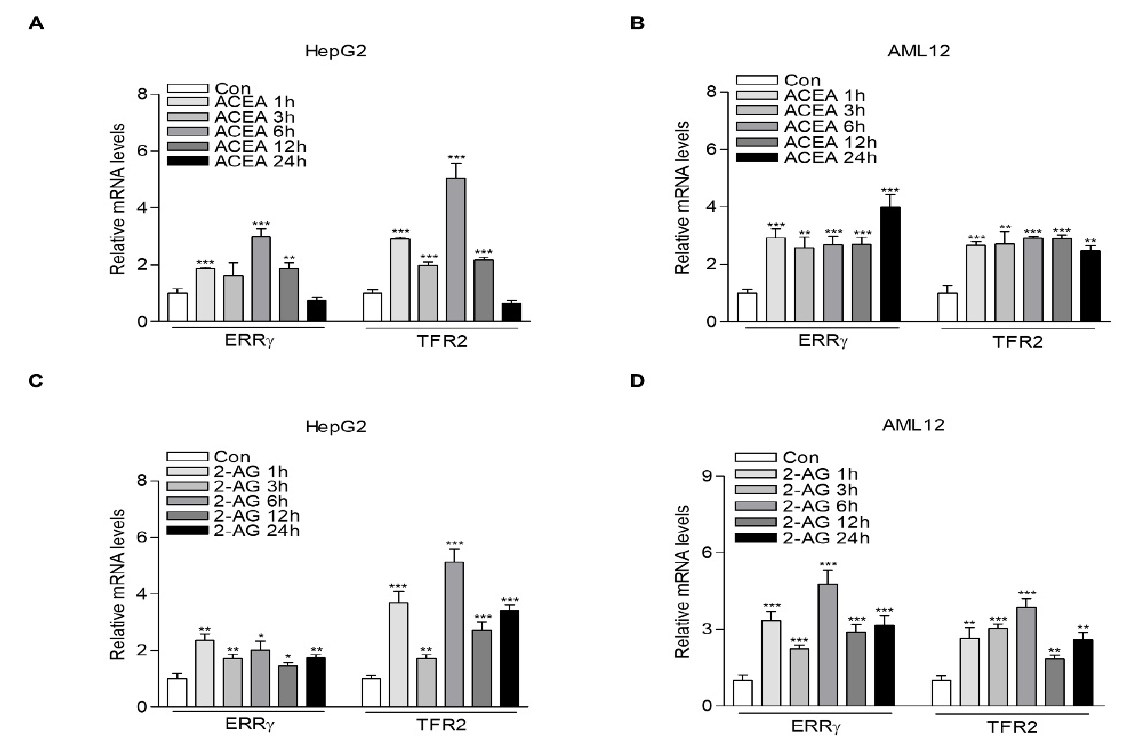
Figure 1. CB1 receptor signaling induces ERR γ and TFR2 mRNA expression. ( A , B ) Q-PCR analysis showing ERR γ and TFR2 mRNA levels. HepG2 ( A ) and AML12 ( B ) cells were treated with ACEA (10 µ M) for the indicated time. ( C , D ) Q-PCR analysis showing ERR γ and TFR2 mRNA levels. HepG2 ( C ) and AML12 ( D ) cells were treated with 2-AG (10 µ M) for the indicated time. All experiments were performed in triplicate and repeated at least three times. Error bars show ± SD. * p < 0.05, ** p < 0.01, *** p < 0.001 by two-tailed Student’s t -test.